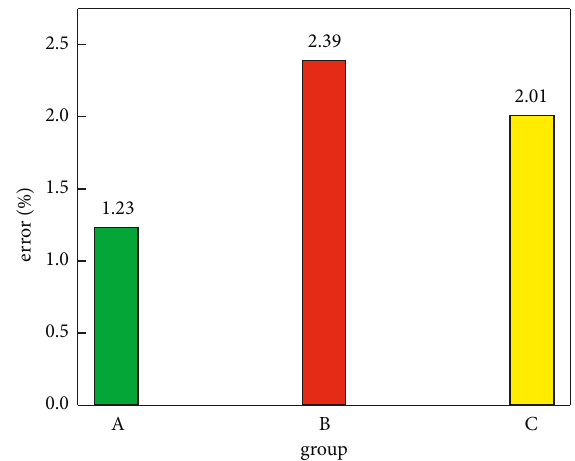
Figure 5: The prediction error of self-media technical content and traditional path-related features using the atrous convolution and LSTM hybrid